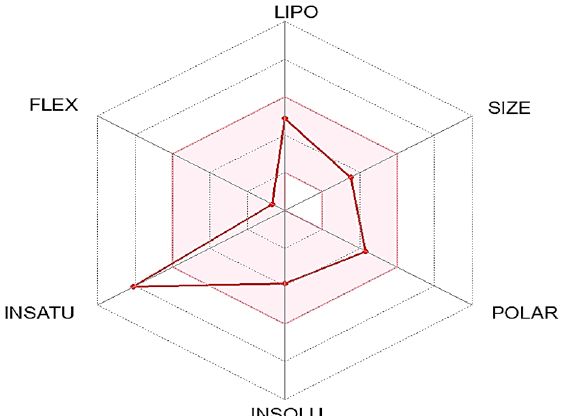
Figure 3. The bioavailability pink area indicates the optimal range for each property (lipophilicity: XLOGP3 between 0.7 and +5.0, size: MW between 150 and 500 g/mol, polarity: TPSA between 20 and 1302, solubility: log S not higher than 6, saturation: fraction of carbons in the sp3 hybridization not less than 0.25, and flexibility: no more than 9 rotatable bonds). Table 13. Pharmacokinetic parameters of C1.